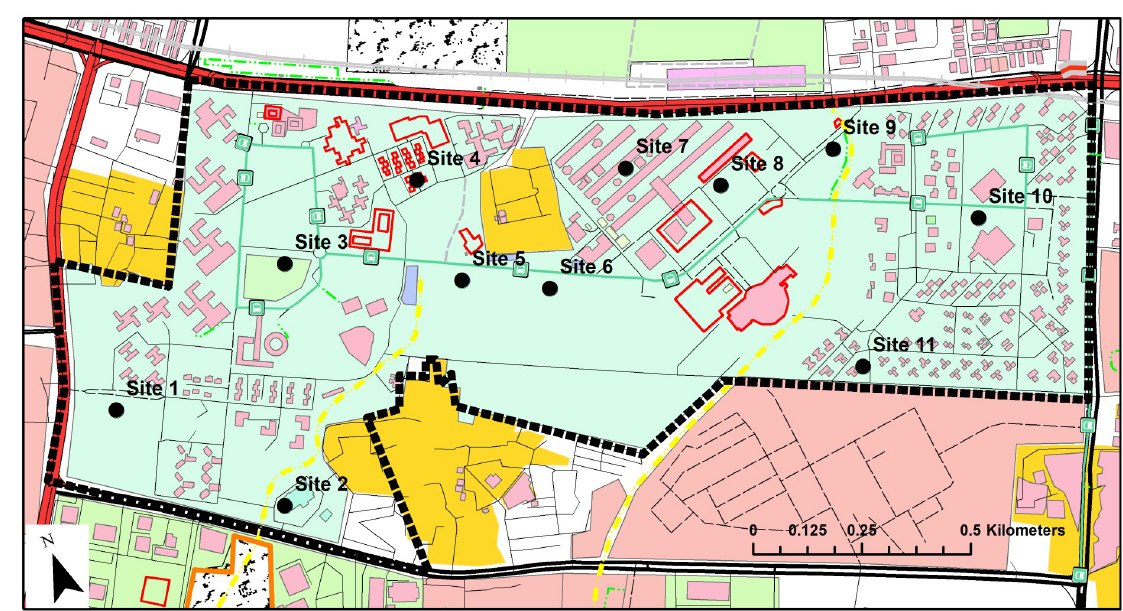
Fig 2. Sampling locations in IIT Delhi campus (India) for in-situ analysis using FP-XRF. Source: OpenStreetMap 1